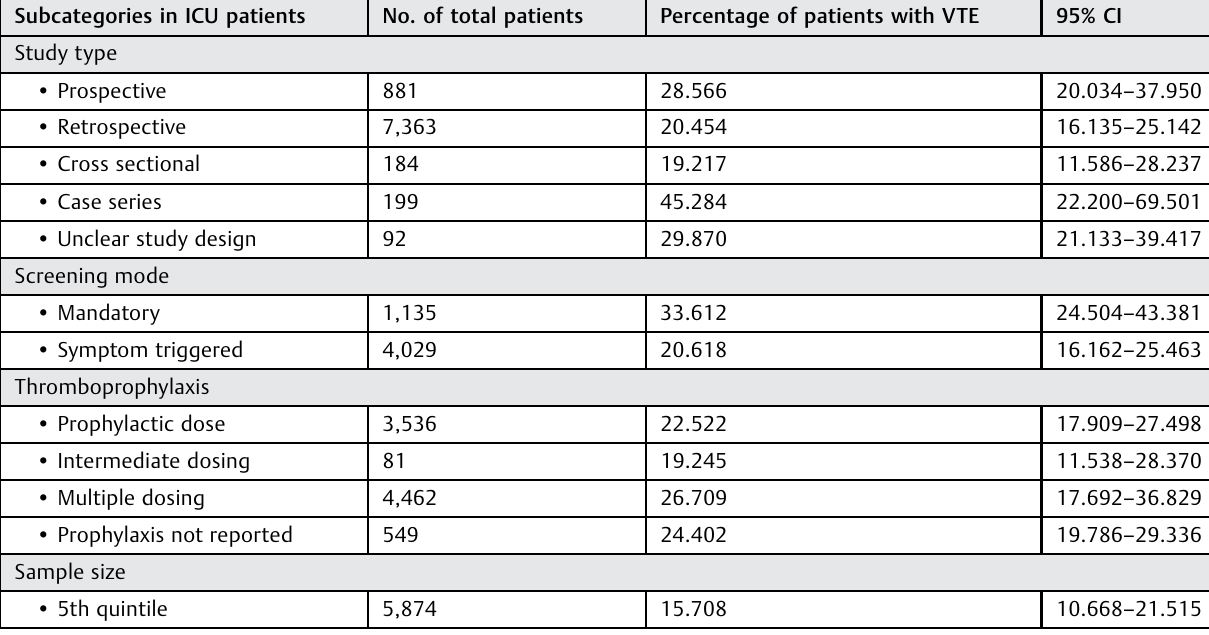
Table 4 Proportion of ICU COVID-19 patients with venous thromboembolism: sensitivity analysis Subcategories in ICU